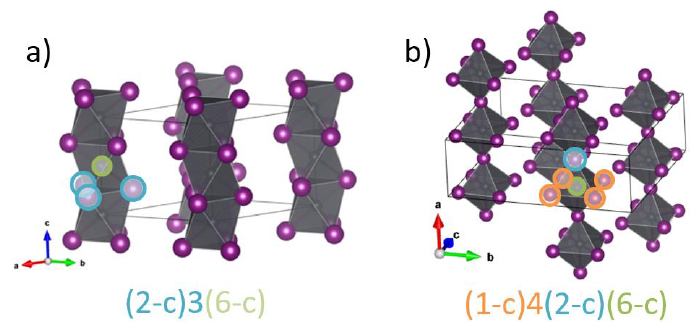
Figure 1. Scheme of net topology definition for binodal ( a ) and three-nodal ( b )